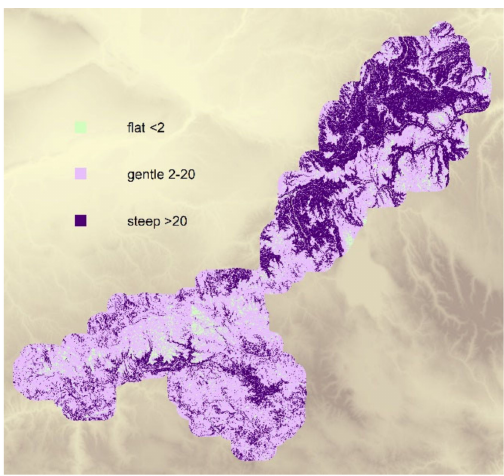
Figure 4. Slope gradients of flat < 2 degrees, gentle slopes 2 to 20 degrees, and steep slopes > 20 degrees in the Umatilla National